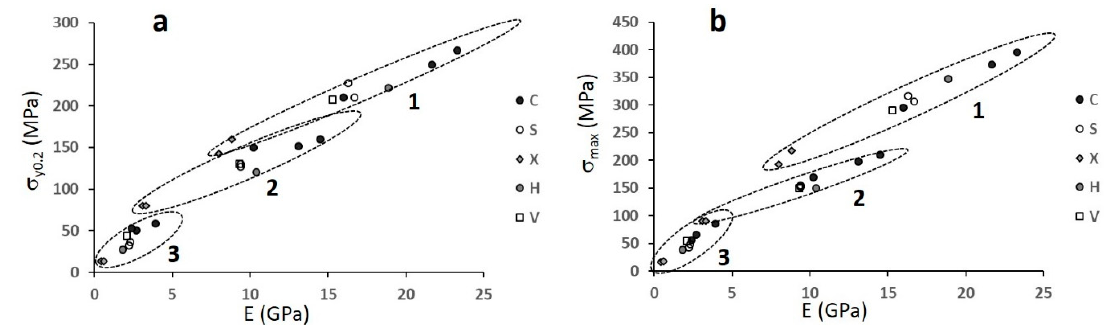
Figure 13. ( a ) Yield strength and ( b ) maximum compressive strength versus Young’s modulus for all the structures investigated. The capital letters refer to structures, numbers, and circled groups to batches.